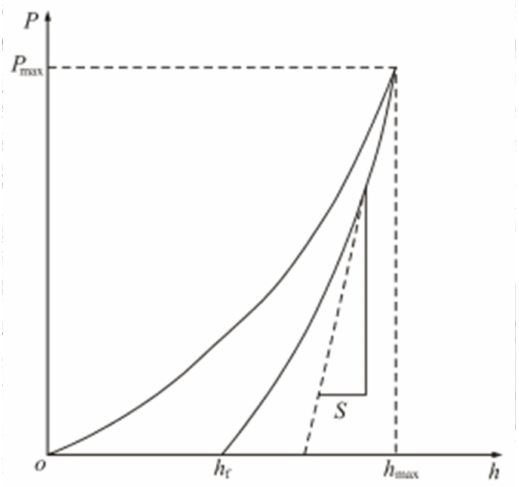
Figure 13. A quasi-static nano-indentation load–displacement